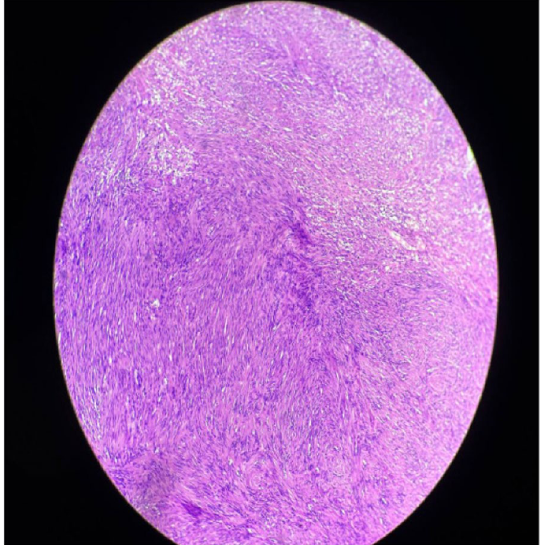
Fig. 5 HPE schwannoma 20 showing palisading of